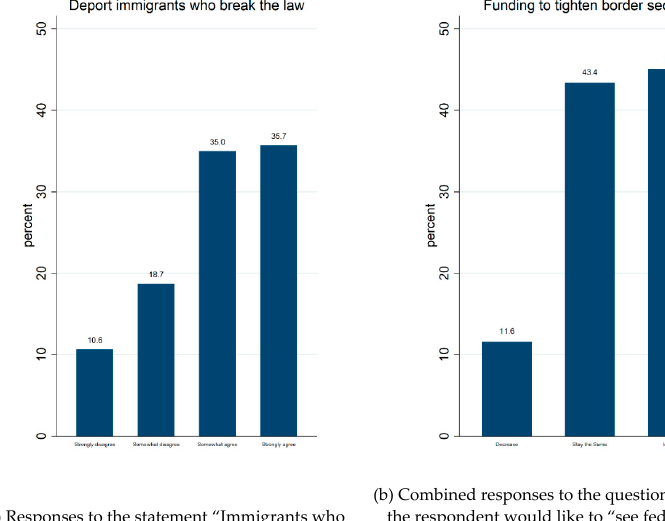
Figure 1. Black Support for Explicit Anti-Immigrant Policy.